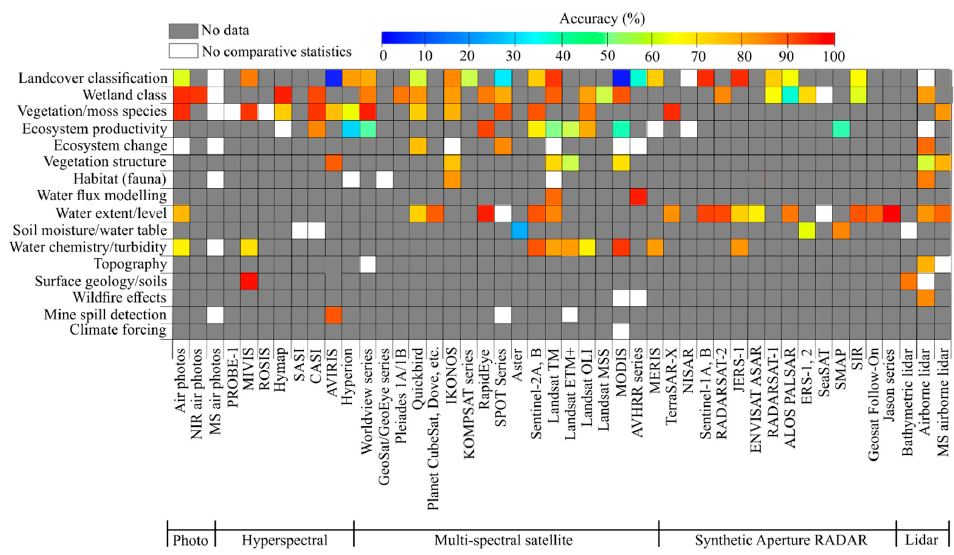
Figure 4. Feasibility of 46 commonly used remote sensing platforms (x-axis) for 16 wetland application areas (y-axis) following Ramsar Convention guidelines (Ramsar Convention on Wetlands, 2018) directed to boreal wetlands, and presented as average validation accuracy (R 2 or users’ accuracy). This is determined as percent correspondence with field data found within the literature. Grey represents applications that were not discussed (per system) in the literature reviewed, and white represents applications that were described but did not contain suitable statistics for comparison in this review. Remote sensing systems are organised within each category (e.g., multi-spectral satellite) from highest to lowest pixel resolution.